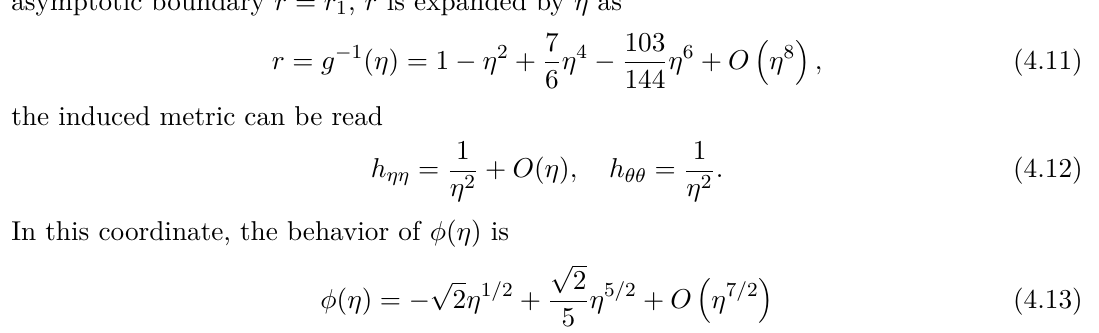
Figure 12 . Configurations when z ( r ) in figure 11 is multiplied by dependency near r = 1 is V ( φ ) ' 0 . 75 φ 2